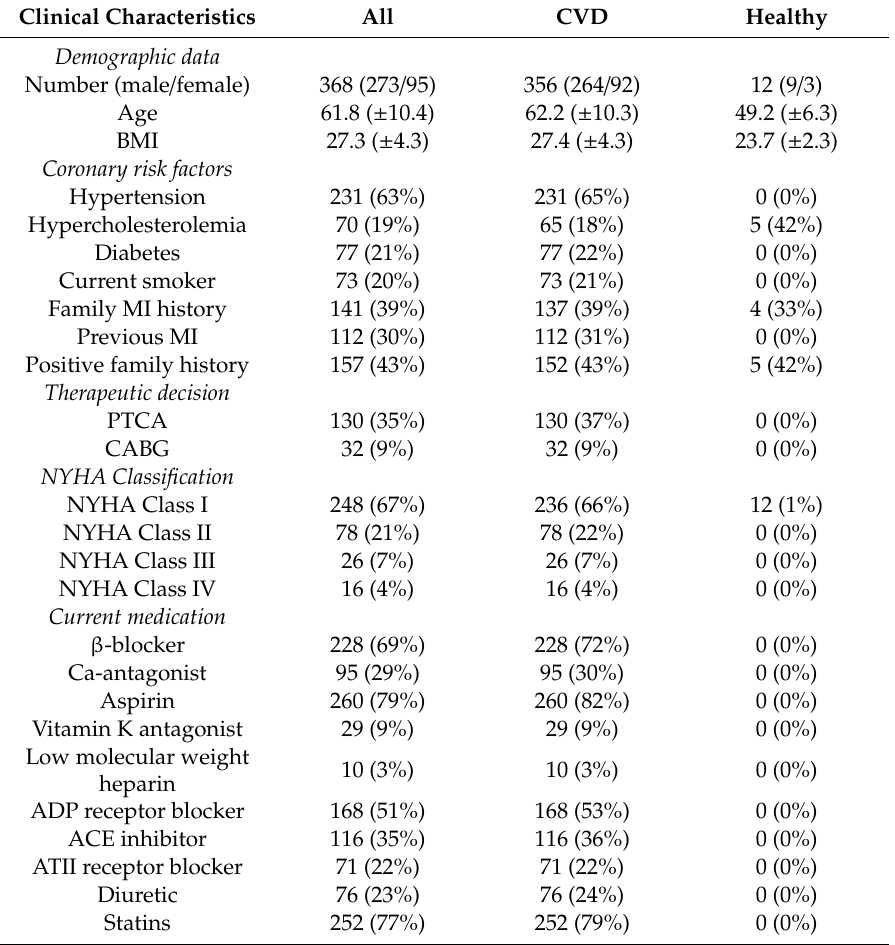
Table 1. Clinical characteristics of the CIRCULATING CELLS